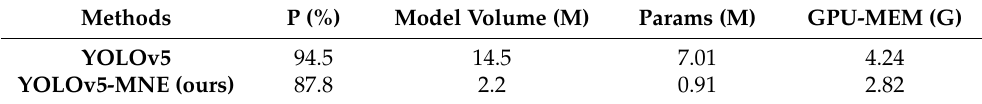
Figure 12. Visualization effect of our experiment on the AIR-SARship 1.0 dataset. Table 6. Performance comparison with the raw YOLOv5 on the AIR-SARship 1.0 dataset.